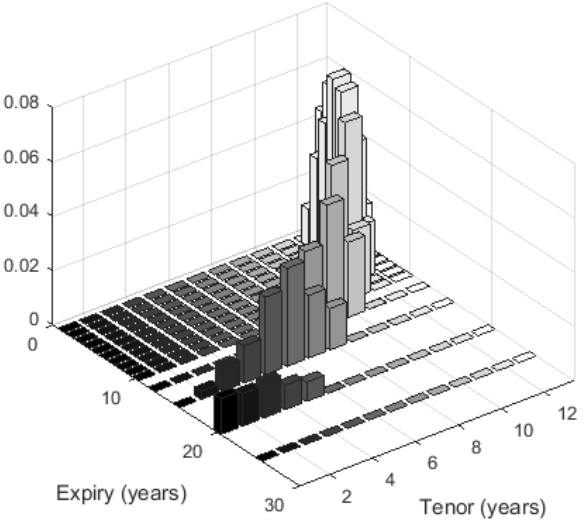
Figure 1. The distribution of Vega risk across maturity and tenor buckets for a 21nc1 receiver ATM Bermudan swaption (in % of total swaption Vega).